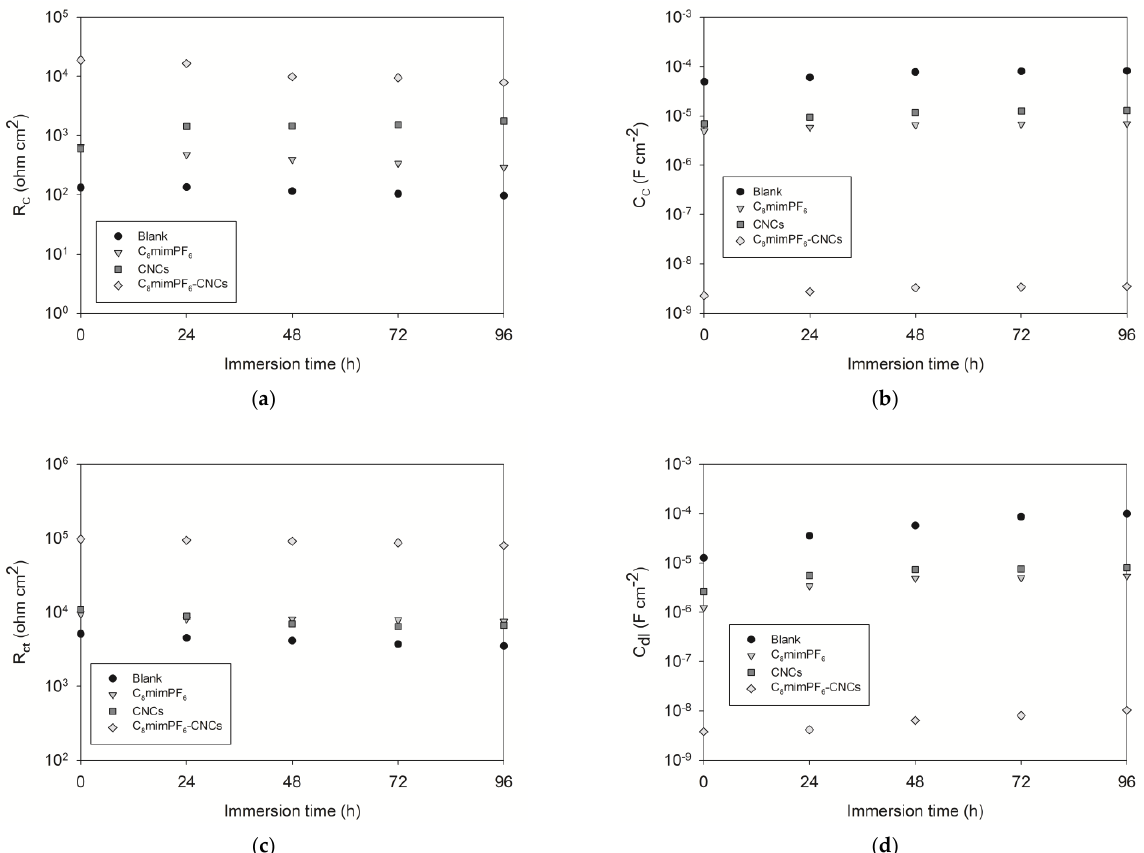
Figure 4. EIS parameters of coated samples in 3.5 wt% NaCl solution at different immersion periods. ( a ) Coating resistance, R C , ( b ) coating capacitance, C C , ( c ) charge transfer resistance, R ct , and ( d ) double-layer capacitance, CPE dl .